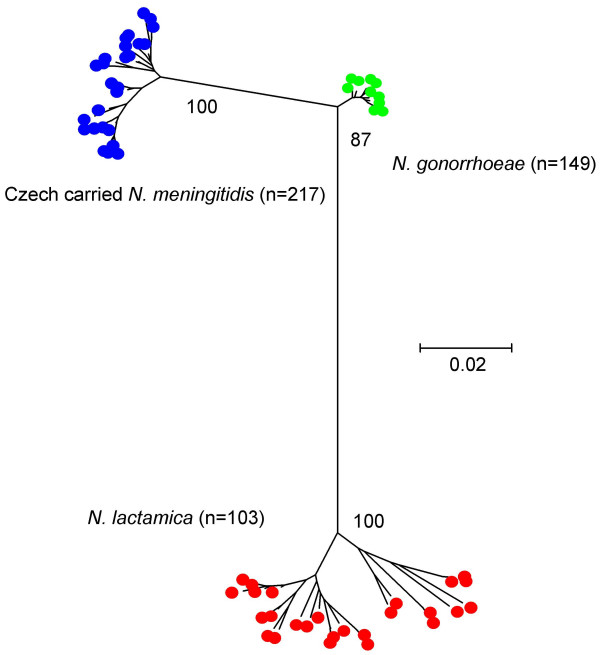
Alleles from a single locus (gdh) resolved species specific clusters. A neighbour-joining tree was constructed from the gdh allele sequences for each species. Bootstrap values are indicated for the main branches (2000 replications).